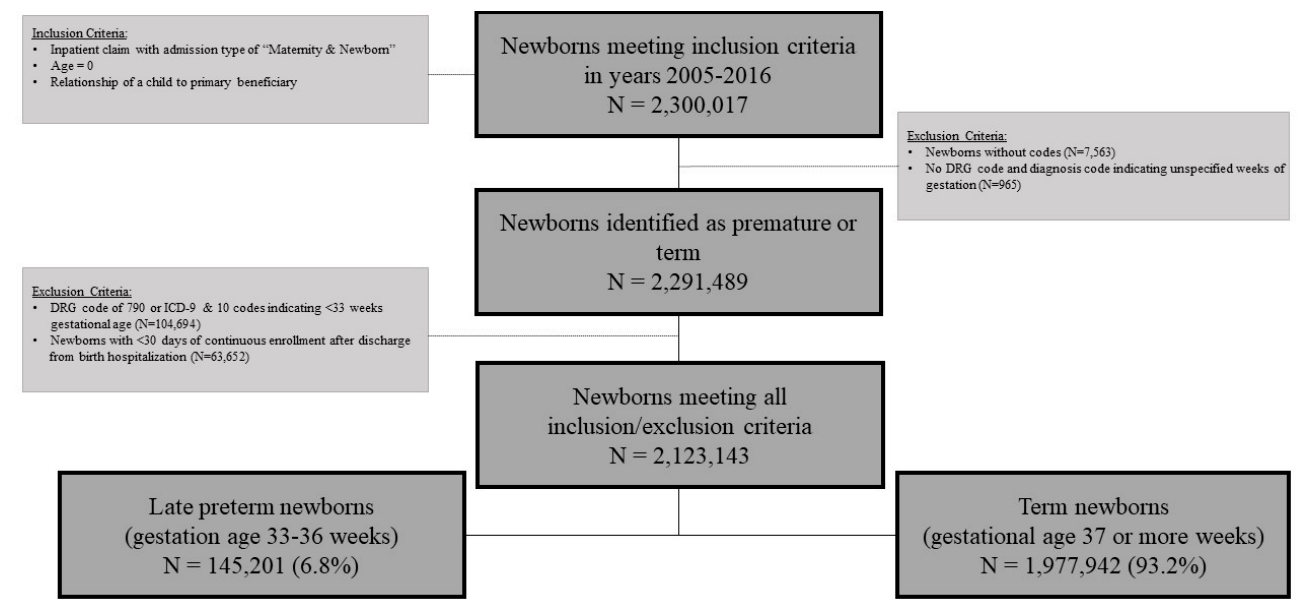
Figure 1. Sample selection: summarization of study sample size.